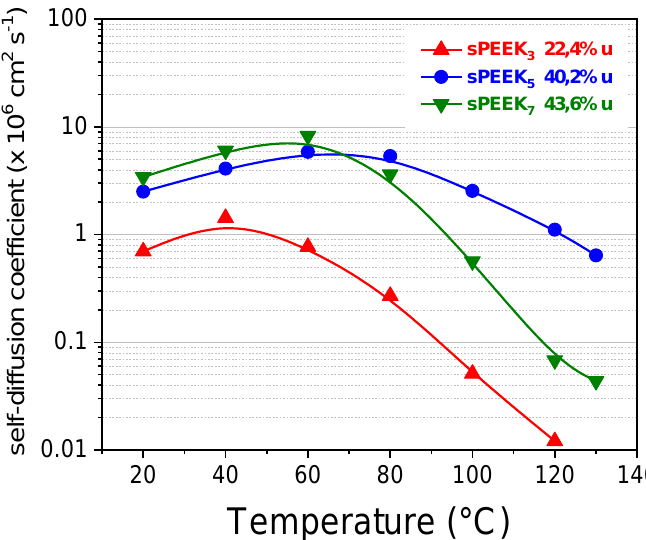
Figure 3. Temperature behavior of the water self-diffusion coefficients as a function of the sulfonation degree.